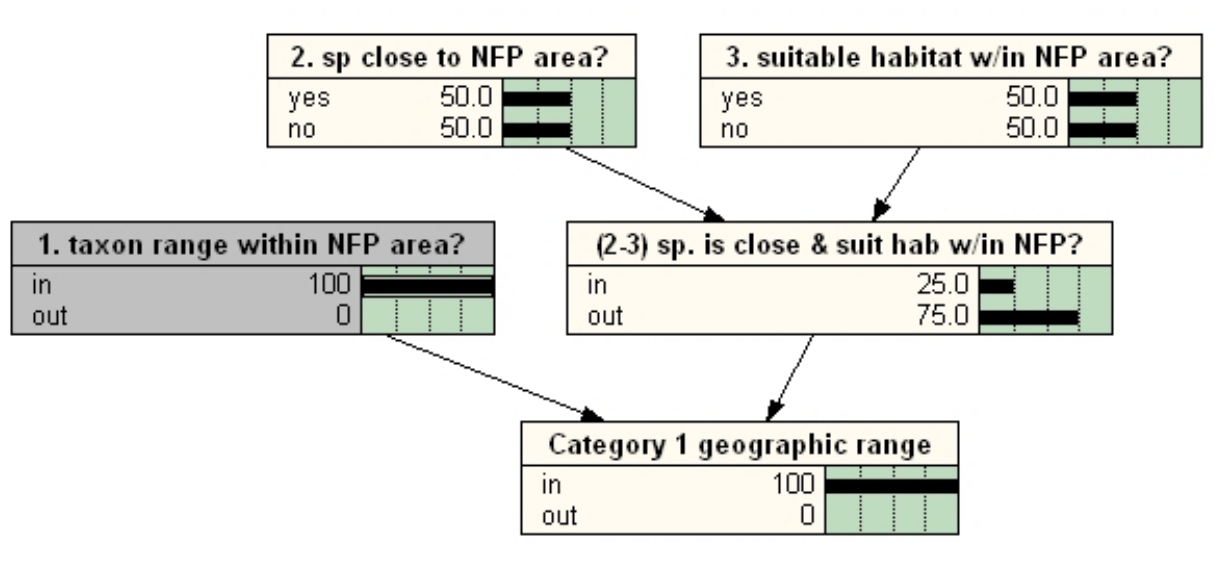
Fig. 2. Bayesian belief network (BBN) submodel for determining evaluation category 1, geographic range conditions f, the species in relation to the Northwest Forest Plan (NWFP). See Table 2 for Record of Decision guidelines used to develop this